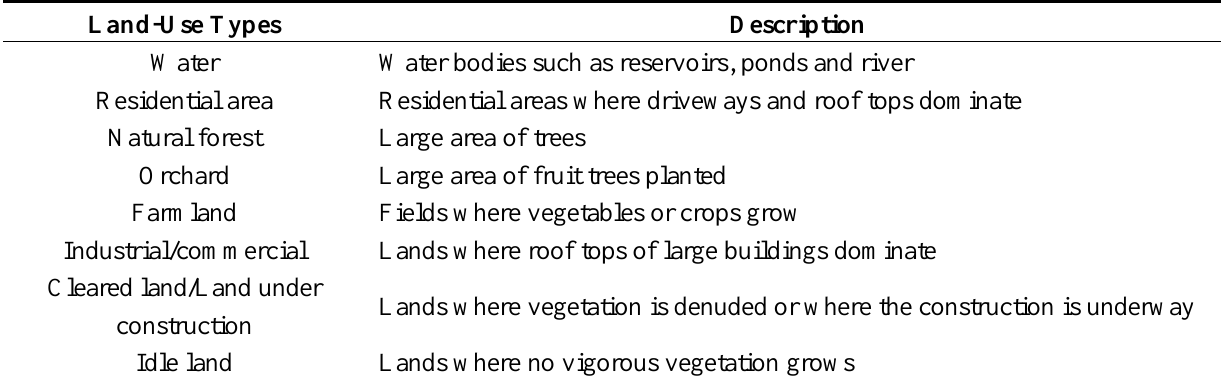
Table 1. Land use classification